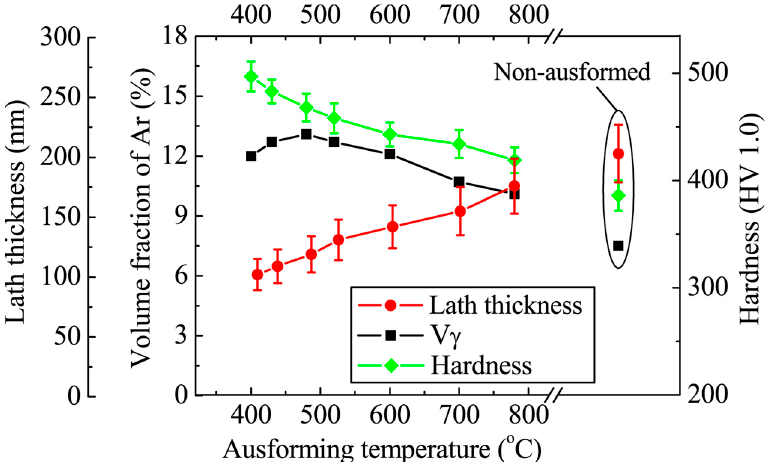
Figure 8. Average thickness of bainitic laths, volume fraction of retained austenite (Ar) and Vickers hardness as a function of ausforming temperature. The data for the non-ausformed sample are also shown for comparison. Extracted from reference [64]. Reproduced with permission from Elsevier, 2017.